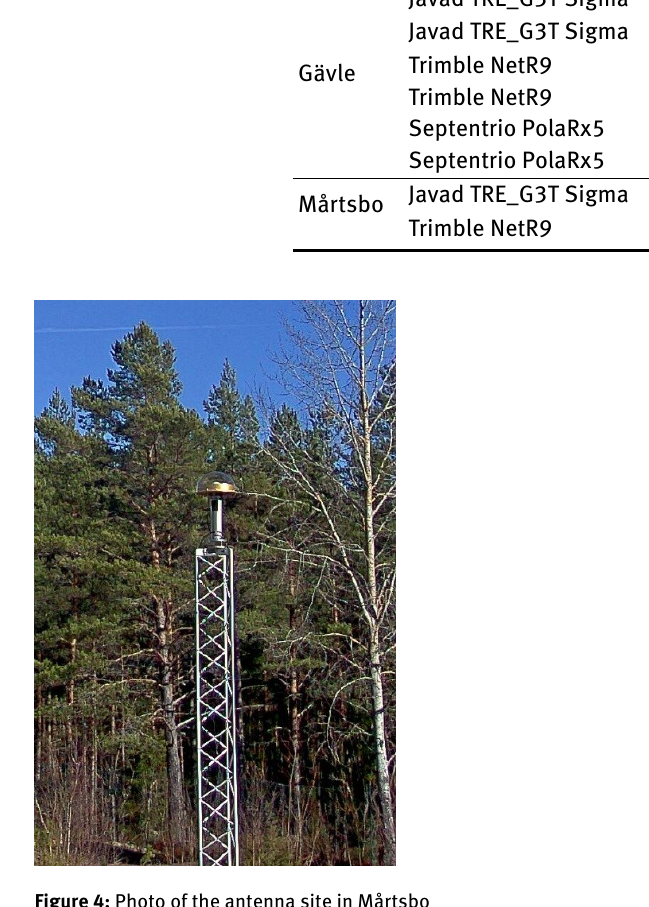
Figure 4: Photo of the antenna site in Mårtsbo